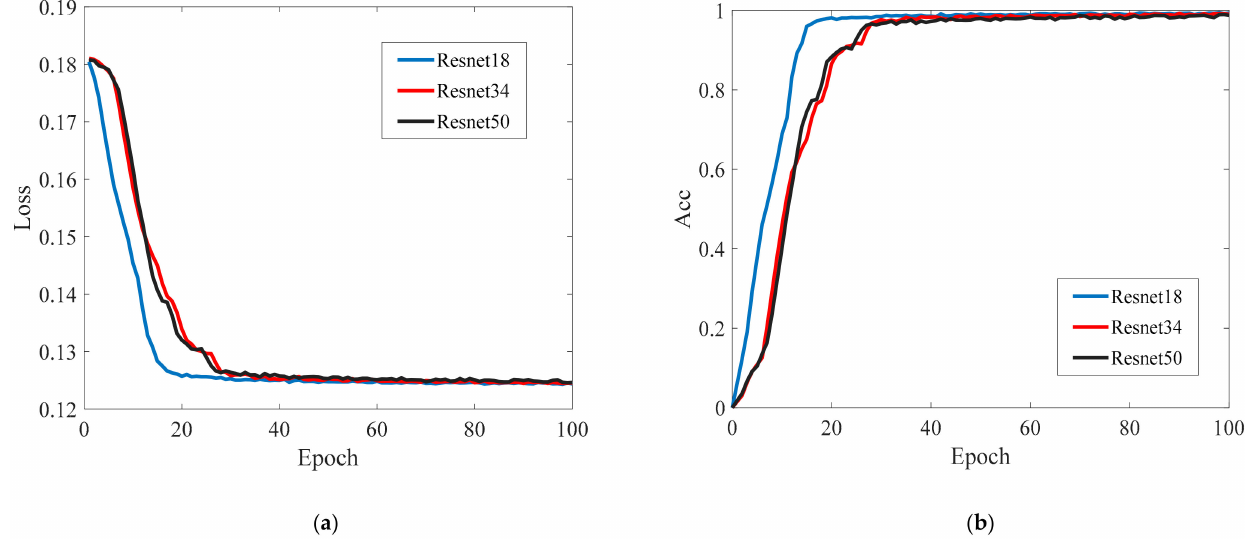
Figure 6. The loss and accuracy comparison of character recognition on ResNet-based models. ( a ) The loss comparison. ( b ) The accuracy